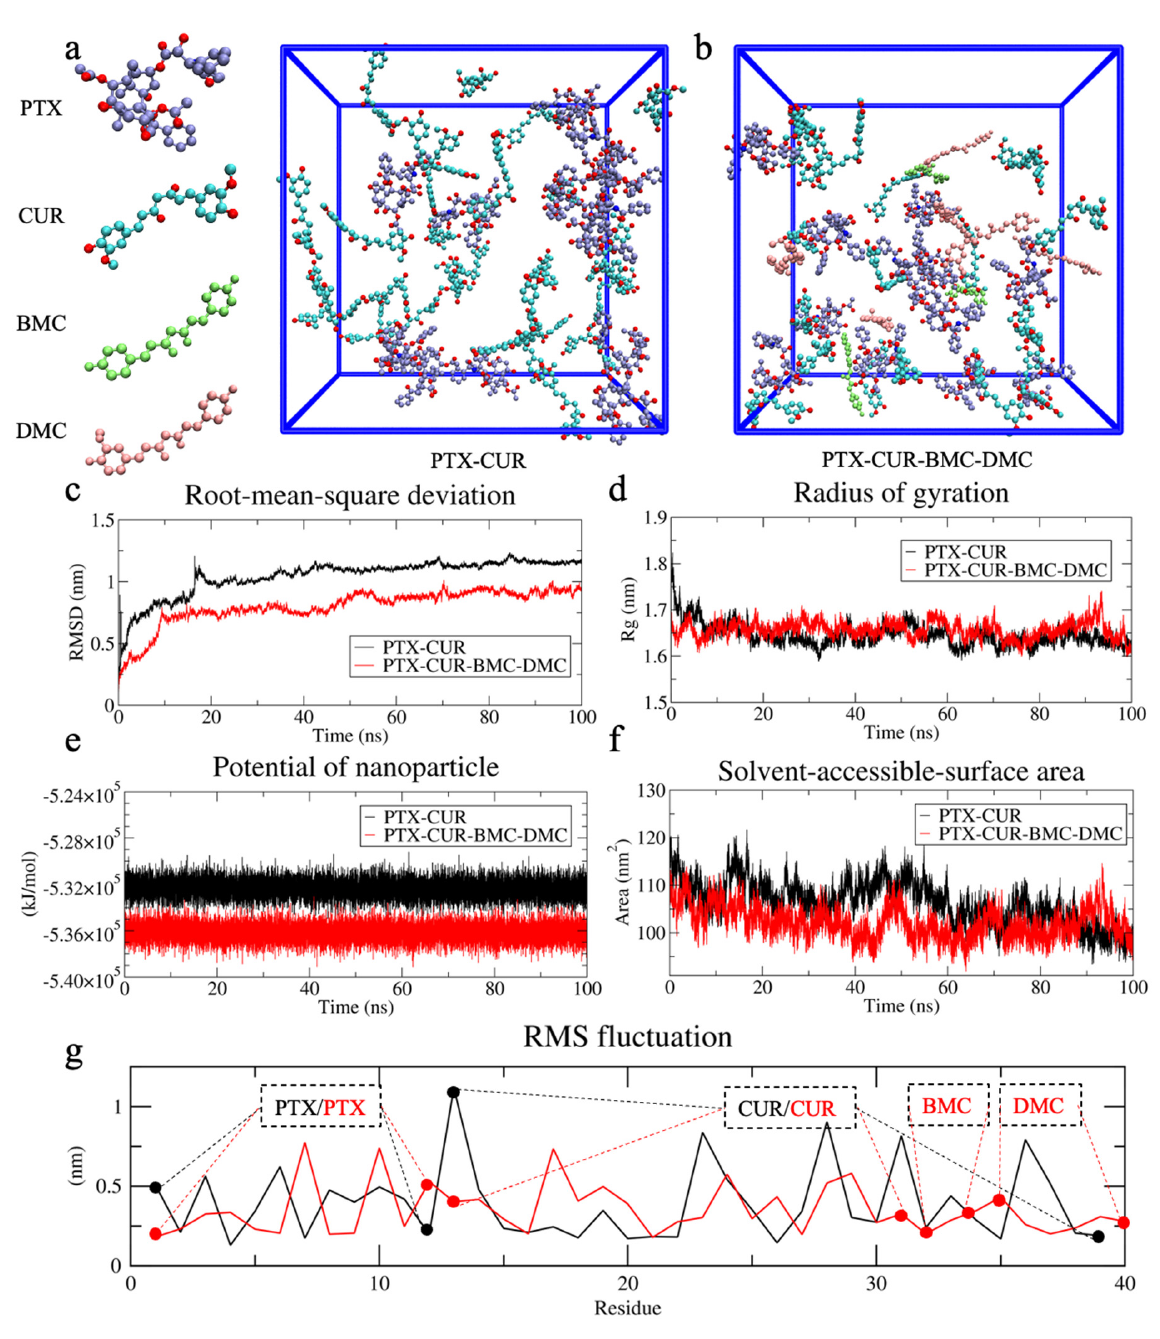
Figure 5. The property representation of NPs, including the initial system state (( a ) for PTX-CUR and ( b ) for PTX-CUR-BMC-DMC), the profile of RMSD ( c ), Rg ( d ), potential energy ( e ), SASA ( f ), and RMS fluctuation ( g ). PTX, CUR, BMC, and DMC stand for paclitaxel, curcumin, bisdemethoxycurcumin, and demethoxycurcumin, respectively (The black and red solid lines stand for the molecular fluctuation in only PTX-CUR and PTX-CUR-BMC-DMC NPs, respectively. The dotted line defines the number and range of each molecule).